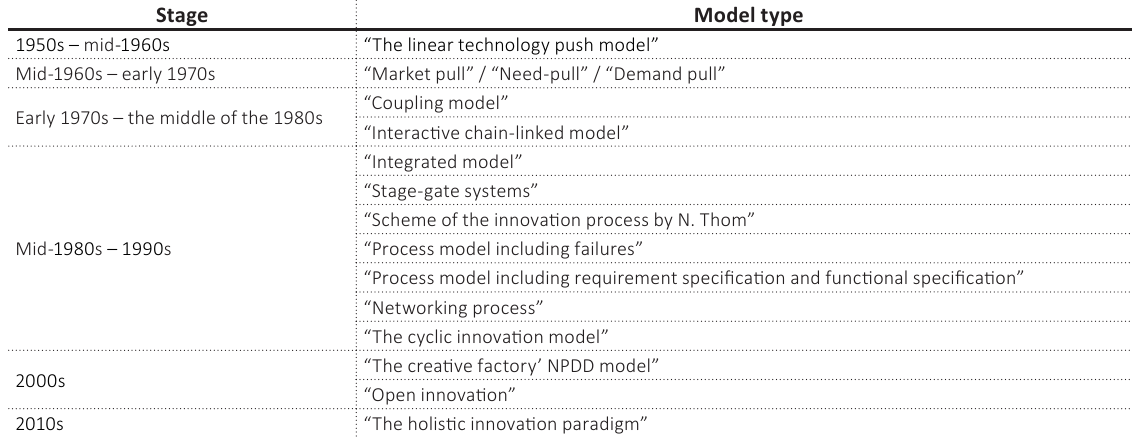
(2009), Rothwell (1994), Van der Duin et al.